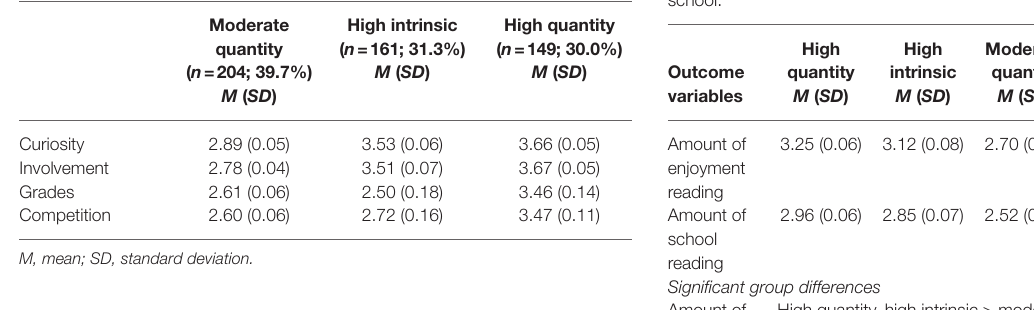
TABLE 4 | Descriptive statistics per latent profile.